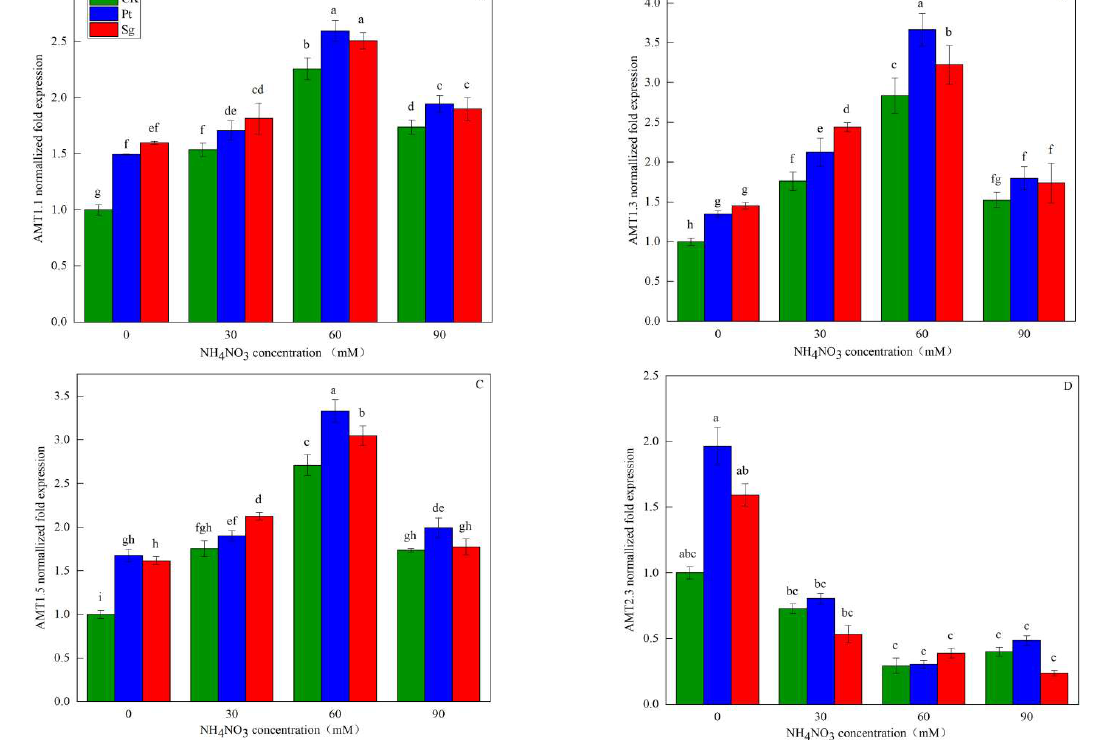
Figure 4. The relative expression of AMT family genes of Pinus massoniana seedlings as a function of NO 3 − solution concentration (A, B, C and D). Note: Vertical bars illustrate standard errors of means ( n = 3). Differences in treatments were analyzed with the Kruskal-Wallis rank sum test. Signif- icant tests ( p < 0.05) were followed by Duncan’s test of multiple comparisons, significant differ- ences are indicated by lowercase letters.CK: control. Sg: Suillus grevillei . Pt: Pisolithus tinctorius . N0: 0 kg · N · ha − 1 a − 1 . N30: normal deposition of 30 kg · N · ha − 1 a − 1 . N60: moderate deposition